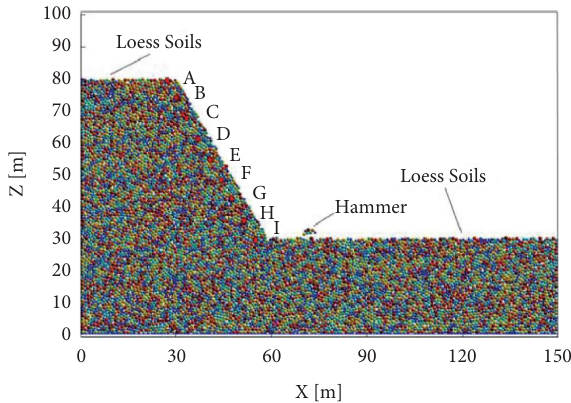
Figure 6: Two-dimensional numerical model.